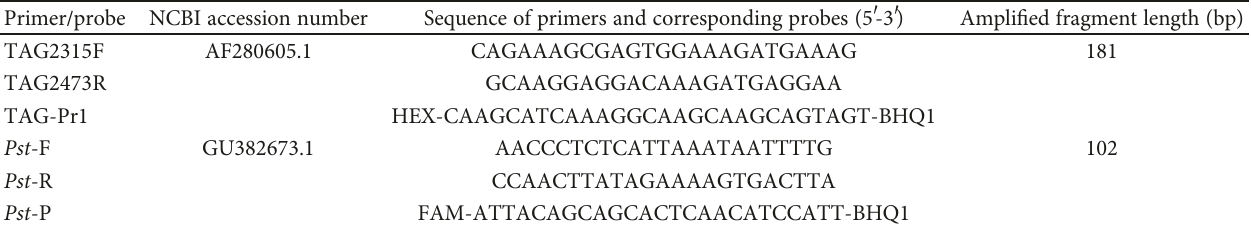
Table 1: Duplex TaqMan real-time PCR primers and probes used in this study. Primer/probe NCBI accession